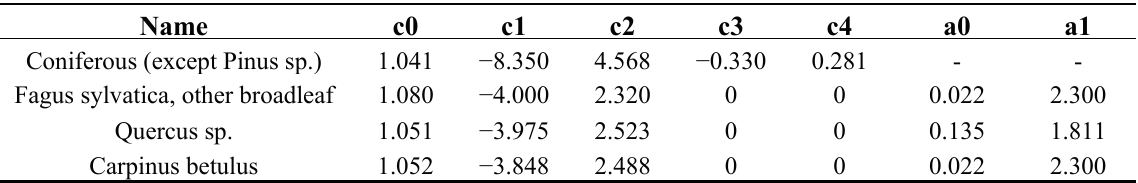
Table A5 . Coefficients c i used in models for biomass in roots ([67] for “Coniferous (except Pinus sp.)”, [68] for “Fagus sylvatica, other broadleaf”, [66] for “Quercus sp.” and “Carpinus betulus”) and a0 and a1 for biomass in foliage [63–65].